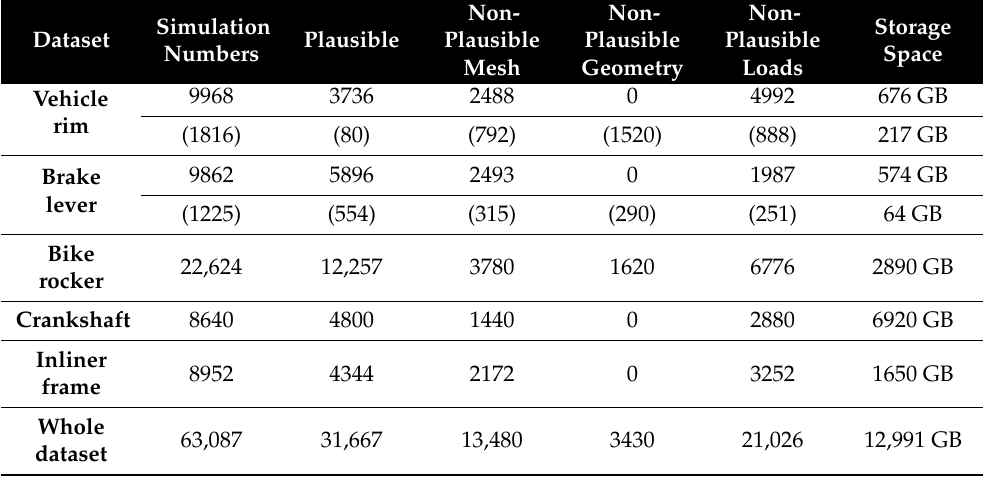
Table 2. General information about the demonstrative study simulation datasets, with the numbers of the additional dataset in brackets.